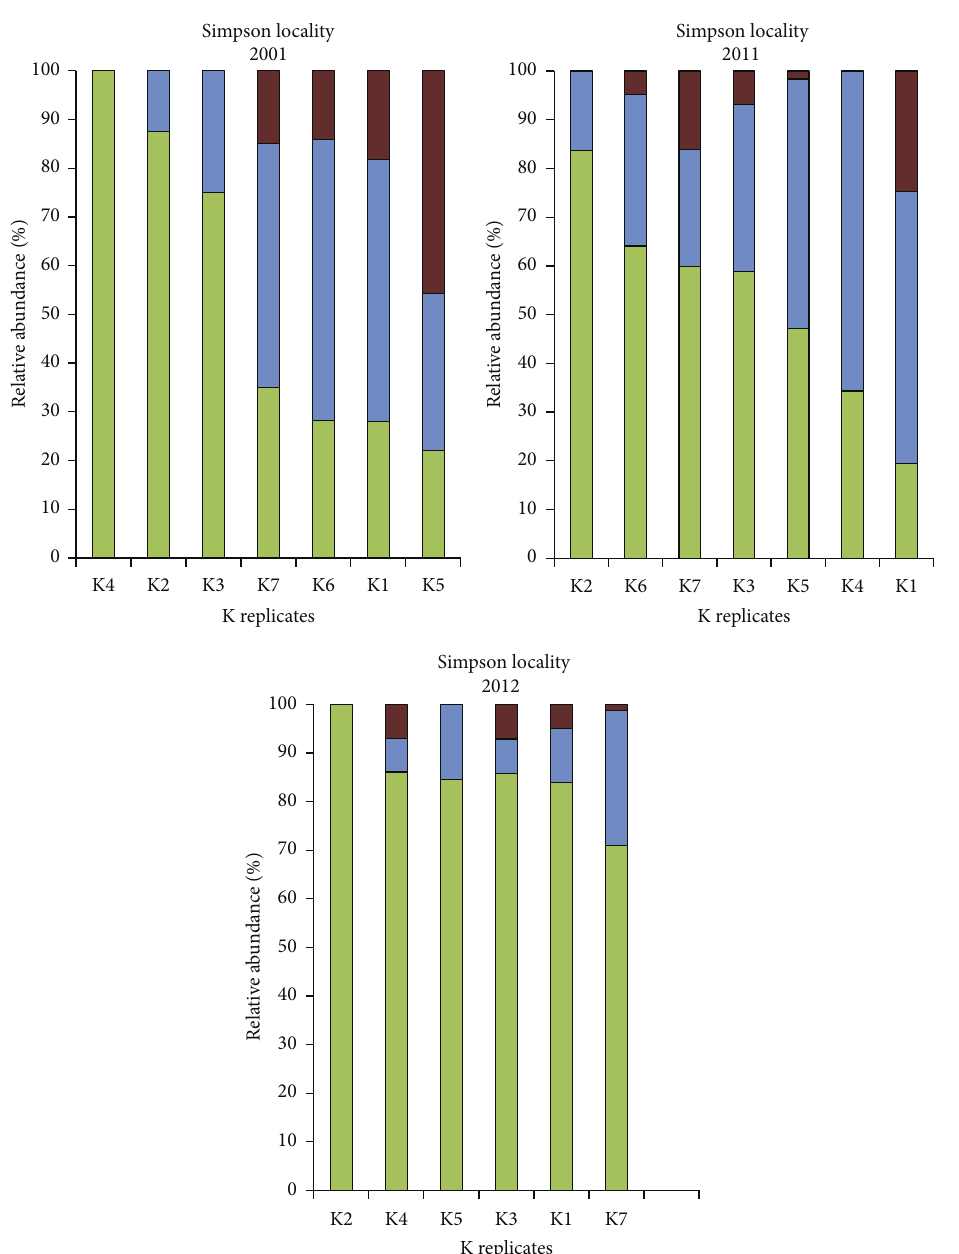
Figure 6: Relative abundance of different taxa at Simpson measured by 1D TRFLP. Soil samples from Simpson plot K are ordered according to relative abundance of g Ca. Nitrososphaera ( I .1 b ) . Colors represent different taxa: the darkest color, red, indicates unclassified Archaea, the midtone color, blue, indicates o NRP-J ( I .1 c ) , and the lightest color, green, indicates g Ca. Nitrososphaera ( I .1 b ) .